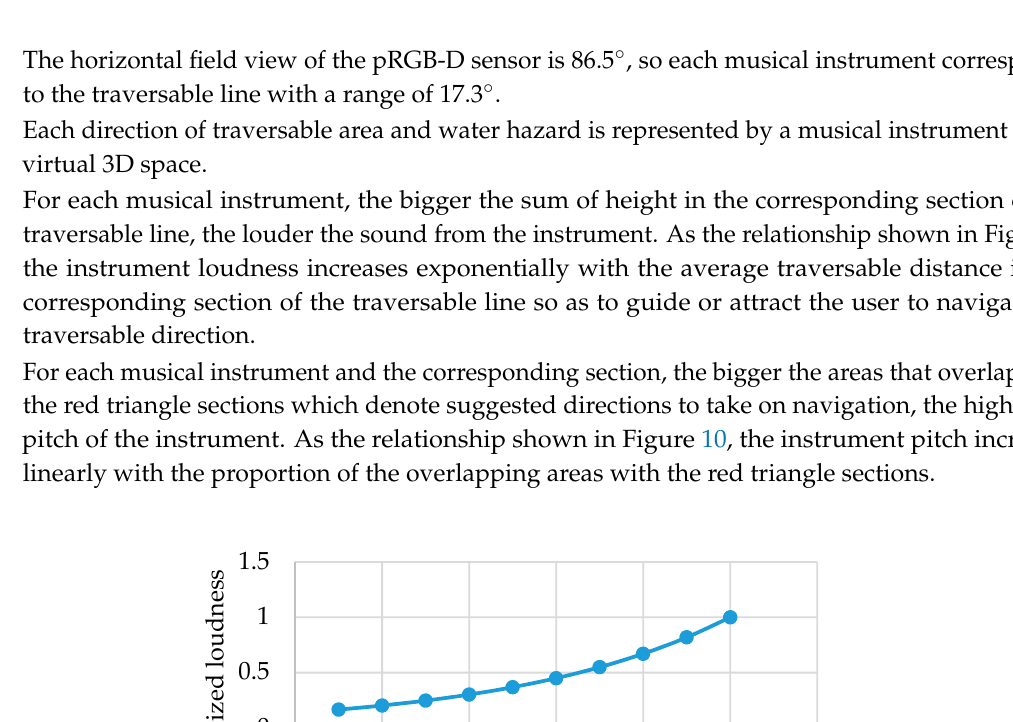
( p ) Figure 11. Results of traversable area and water hazard detection in indoor and outdoor environments. ( a , e , i , m ) Left color images; ( b , f , j , n ) Depth images; ( c , g , k , o ) Traversable area and water hazard detection results denoted respectively by the green and magenta masks on the left color images; ( d , h , l , p ) Farthest traversable lines as stereo sound feedback interface.